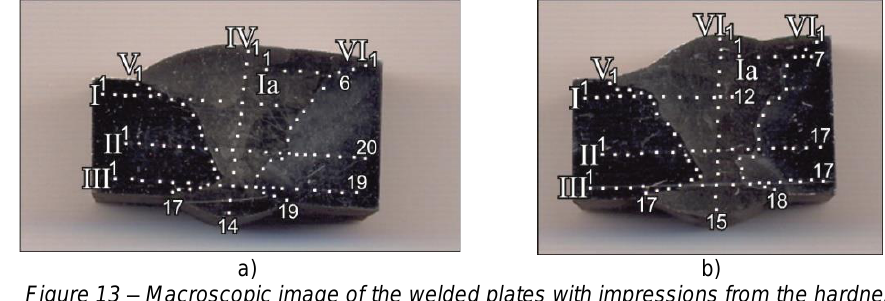
Figure 13 – Macroscopic image of the welded plates with impressions from the hardness